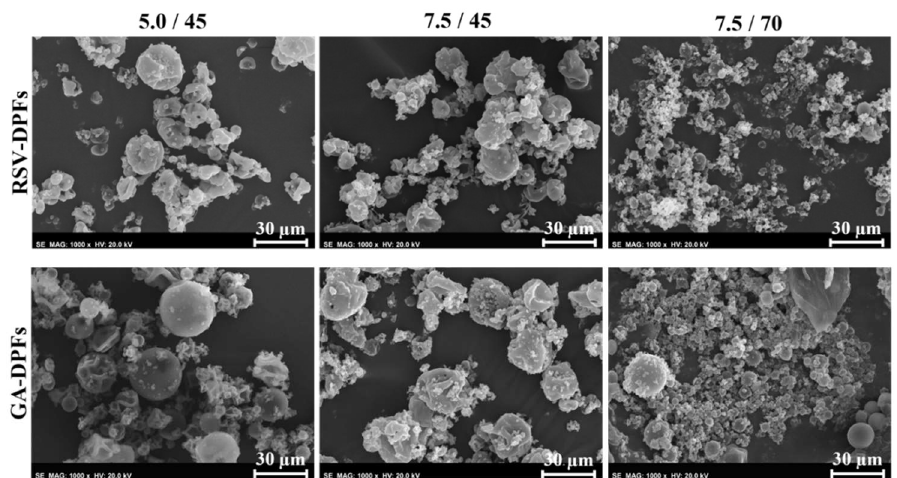
Figure 4. SEM images of both RSV–DPFs and GA–DPFs dry powder formulations with 5.0 and 7.5 % w / v of solids and 45 and 70 % v / v of Ethanol at 1000× magnification.